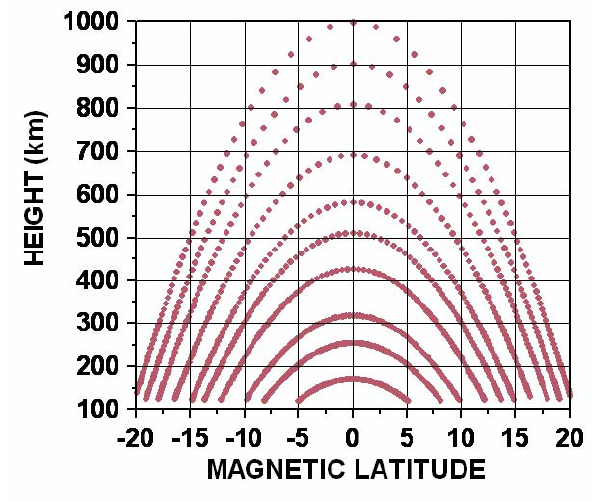
Fig. 1. Set of dipole magnetic field lines illustrating the height ver- sus magnetic latitude grid used in the LION model, with 99 points along each field